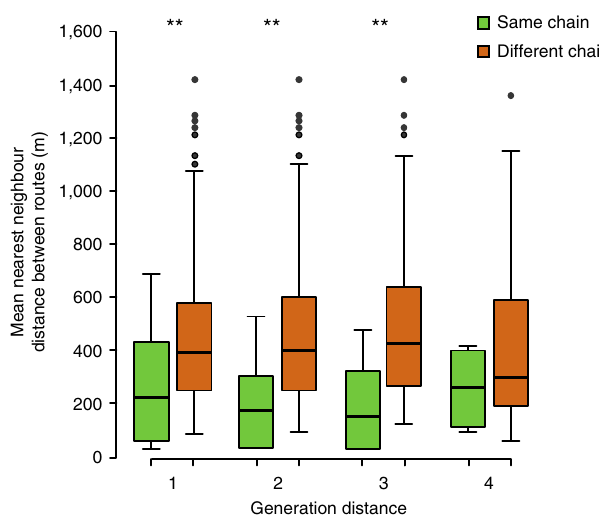
Figure 3 | Route similarities within and between chains of generations in the experimental group. Mean nearest-neighbour distances (see Methods) are plotted between flights within the same chain and between different chains in the experimental group, at all possible generation distances (that is, differences in ordinal generation numbers). Larger values indicate lower route similarities. Each box extends between the lower and upper quartiles, the horizontal line within the box corresponds to the median and whiskers show the range of the data, except for outliers indicated by circles. Mann– Whitney–Wilcoxon test: ** P o